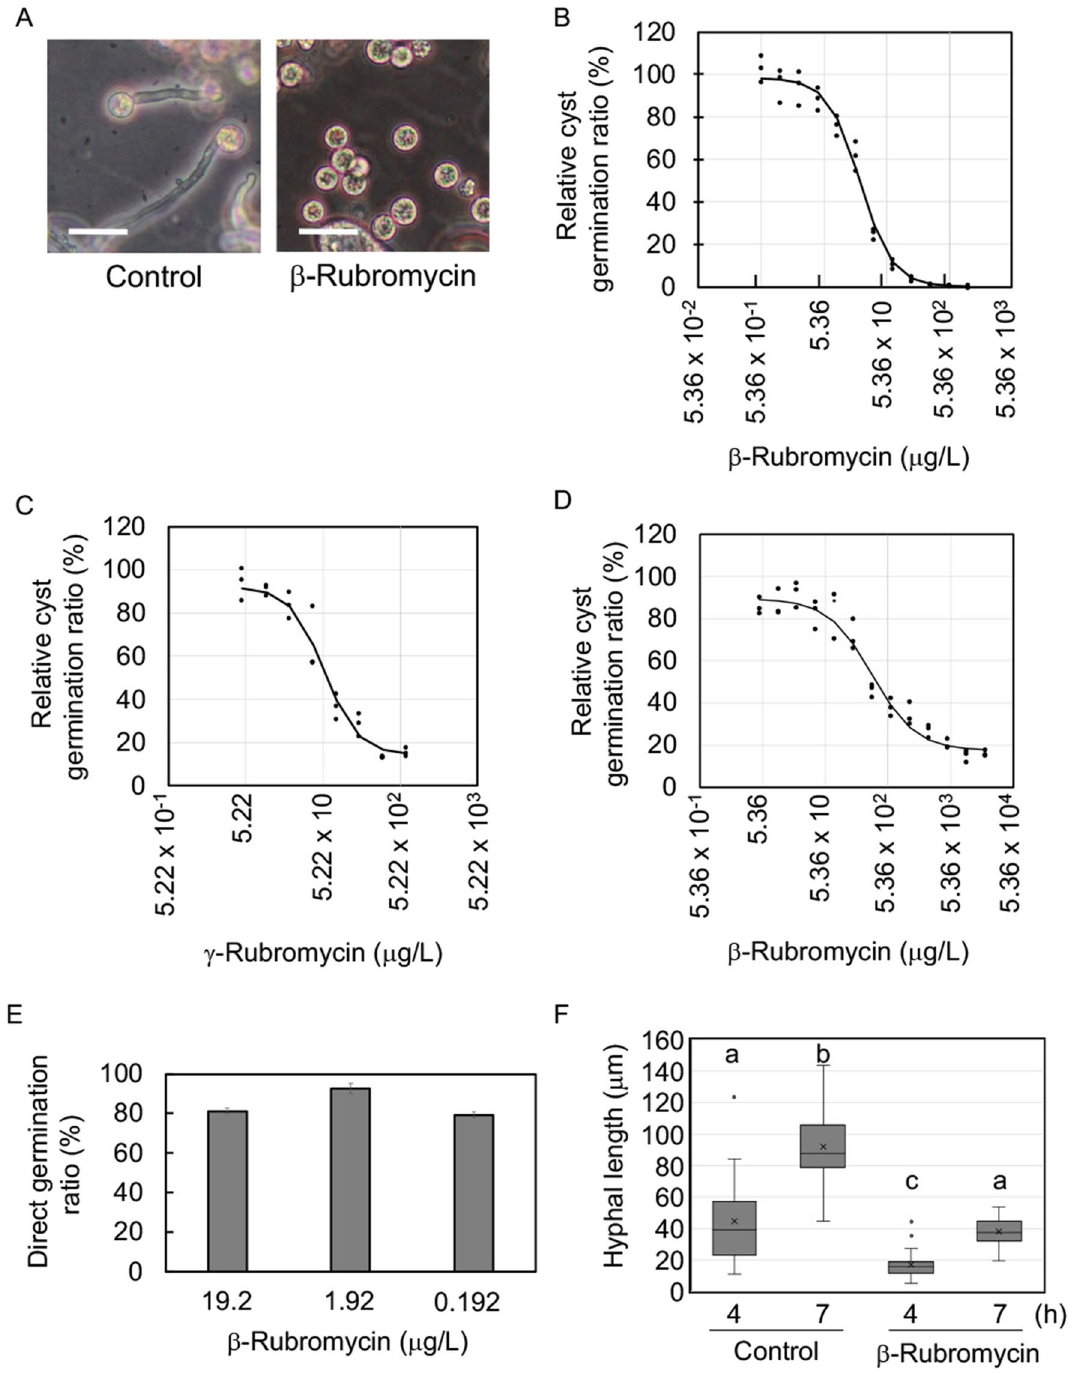
Figure 2. Effect of β-rubromycin and γ-rubromycin on Ph. infestans cyst germination or direct germination from sporangia. The indicated amount of each compound was added to sporangia or cysts, which were incubated at 10 °C for zoosporogenesis or 18 °C for direct germination for indicated time period and then scored ( A – D ). ( A ) Representative images of cysts with or without 1.0 mg/L β-rubromycin, showing the inhibition of cyst germination (at 6-h post stimulation of cyst germination). Bar is 50 μm. The indicated amount of β-rubromycin or γ-rubromycin was added to sporangia ( B and C ). Cyst germination was scored at 6-h after addition of a final concentration of 2.5 mM Ca(NO 3 ) 2 to zoospores. Comparison of the cyst germination rates in the presence of β-rubromycin ( B ) and γ-rubromycin ( C ). ( D ) The indicated amount of β-rubromycin was added to cysts just after adding a final concentration of 2.5 mM Ca(NO 3 ) 2 to zoospores, and which were incubated for 6 h at 18 °C and then cyst gemination was scored. ( E ) Effect of β-rubromycin on germination from sporangia. The indicated amount of β-rubromycin was added to sporangia and kept at 25 °C to assess the direct germination rate after 96 h. ( F ) Effect of β-rubromycin on hyphal elongation at 25 °C. The sporangium suspension was kept at 25 °C with or without 1.0 mg/L β-rubromycin. The length of hyphae was measured under a microscope at indicated time points. Letters indicate significant difference between groups ( p < 0.05, one-way ANOVA). Each experiment was performed three times which contained three biological